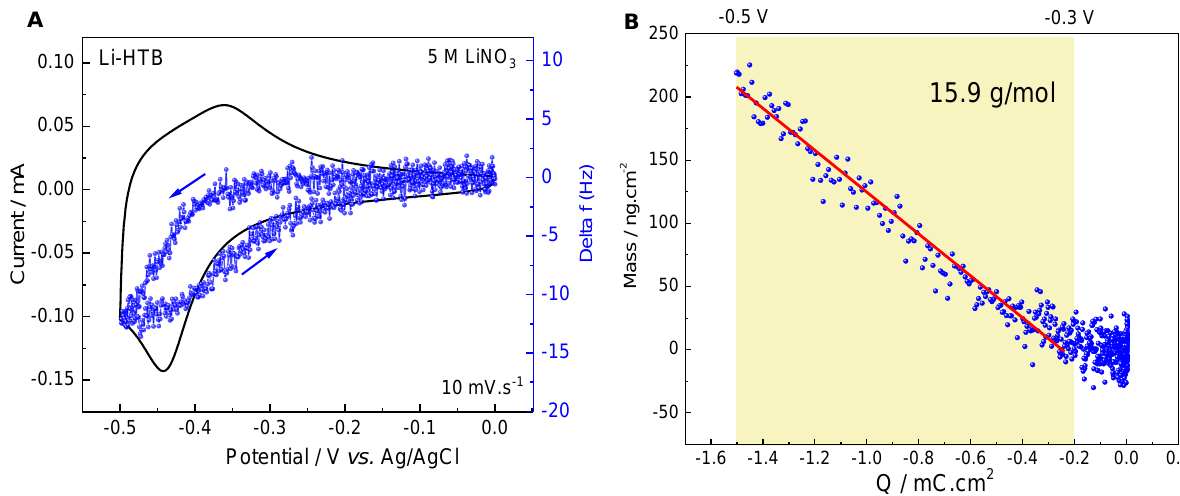
Figure 4. EQCM measurements: ( A ) CV profile and EQCM frequency response for Li-HTB and ( B ) electrode mass change versus charge during the polarization in 5 M LiNO 3 , recorded at 10 mV.s − 1 vs. Ag/AgCl as the reference electrode.